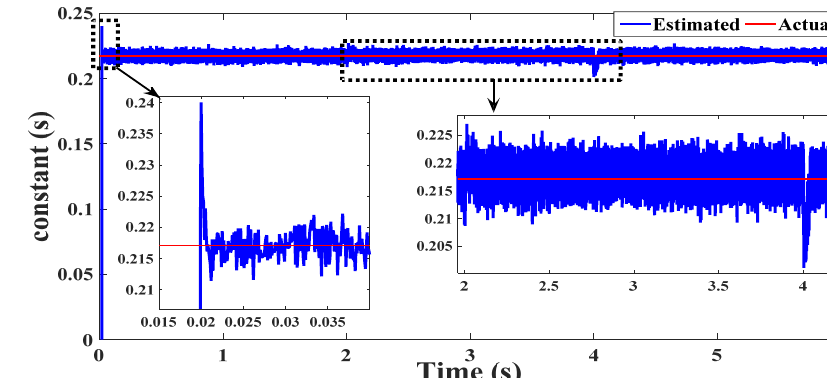
Figure 23. Estimated and actual rotor time constant.